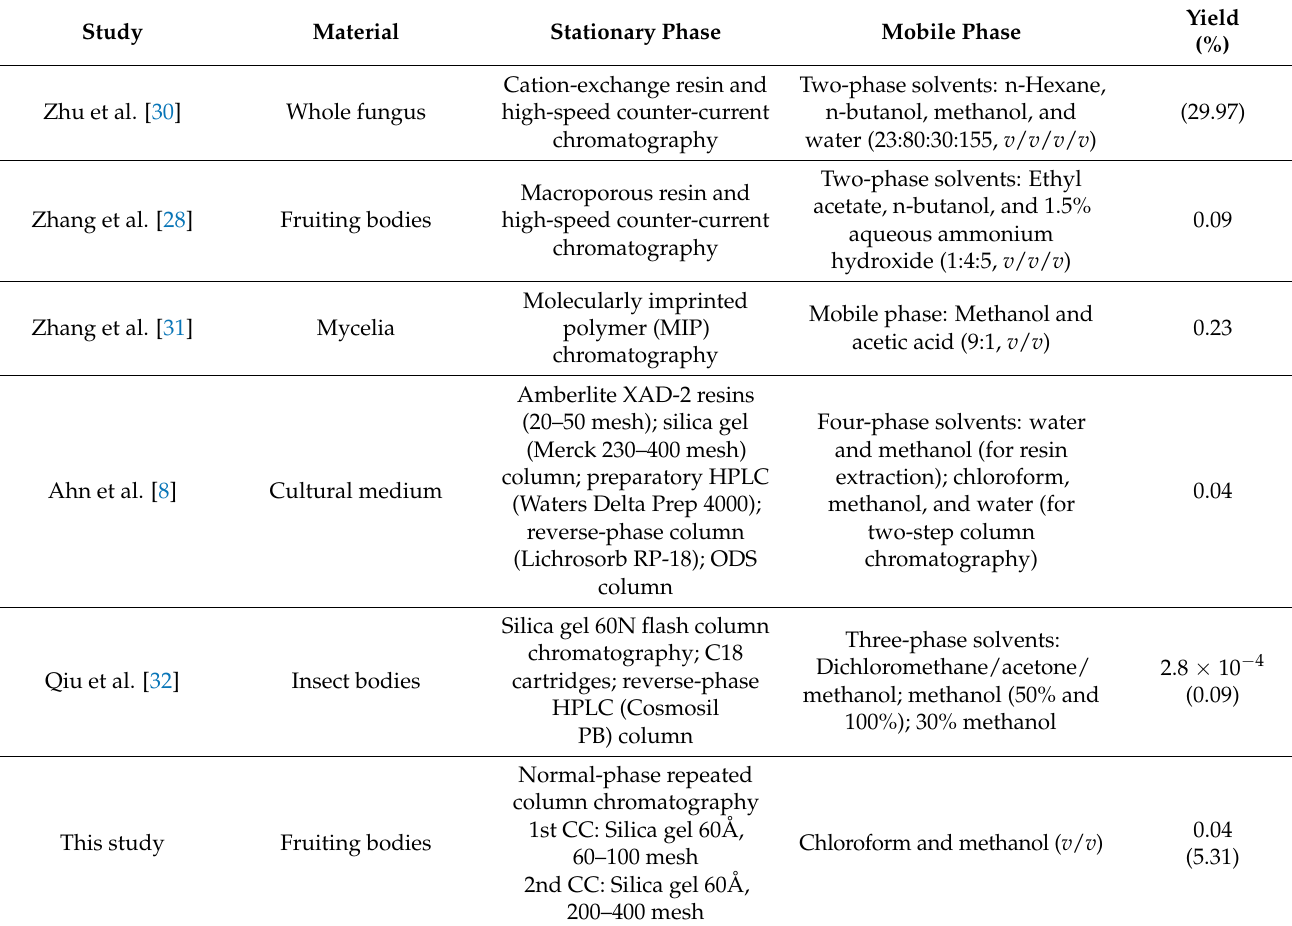
Table 5. Recent column chromatographic methods for isolation and purification of cordycepin from Cordyceps militaris